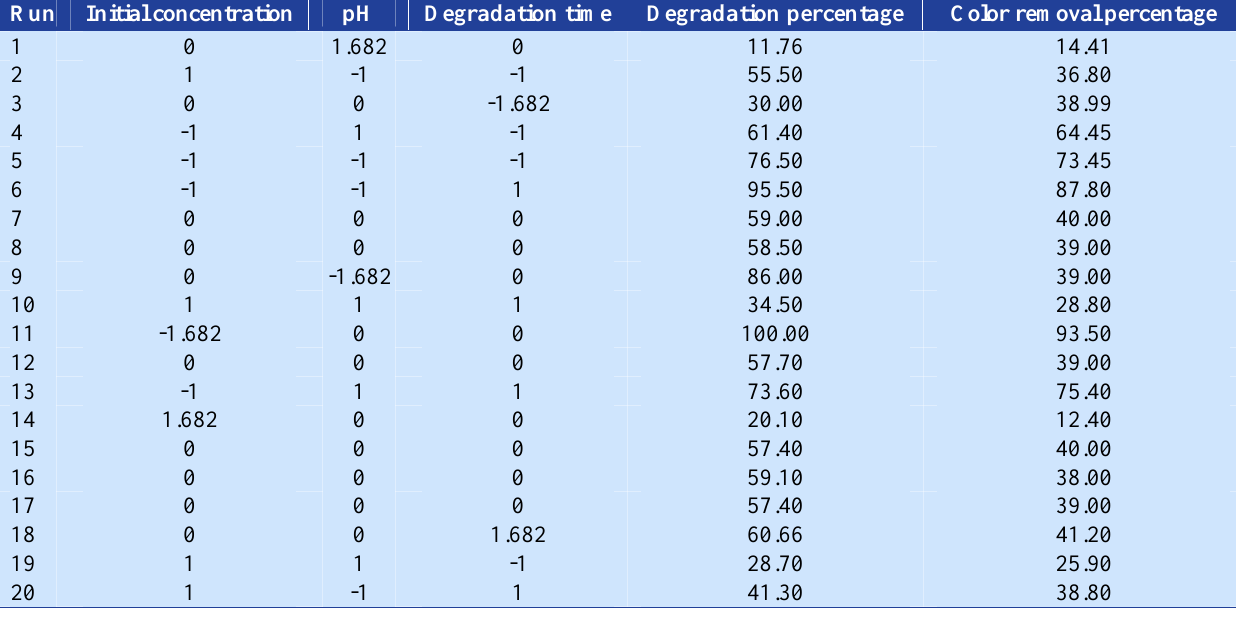
Table 1. The experimental central composite design (CCD) matrix and results Run Initial